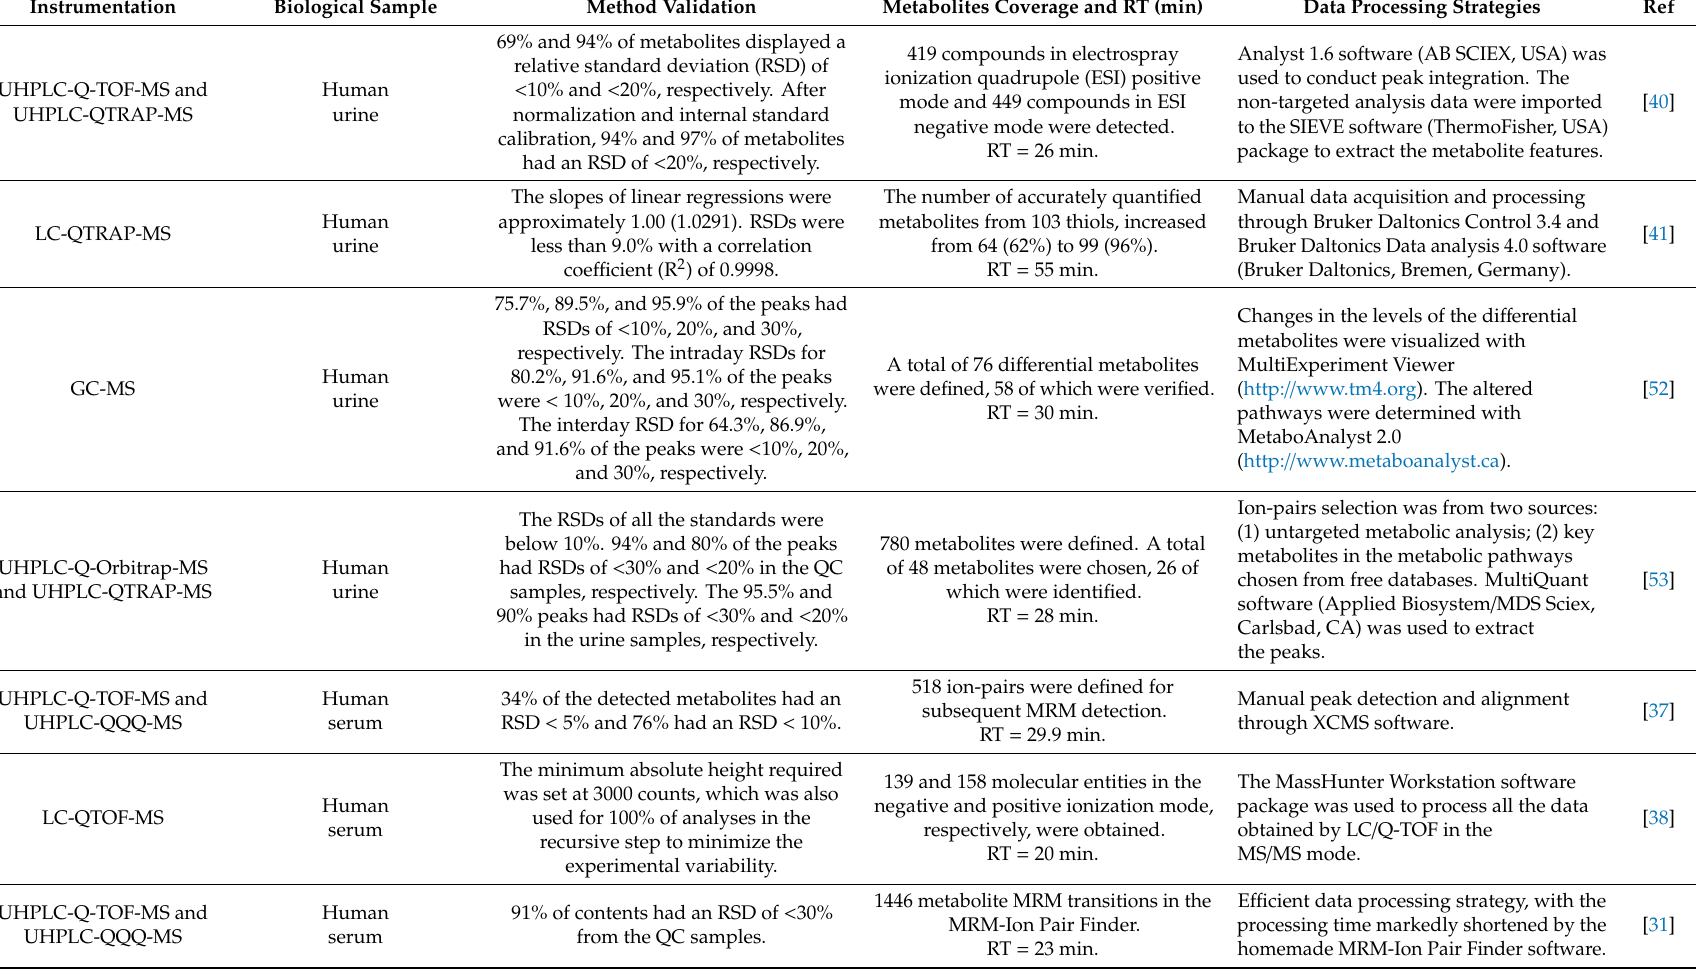
Table 1. Summary of the performance and analytical considerations from di ff erent hybrid